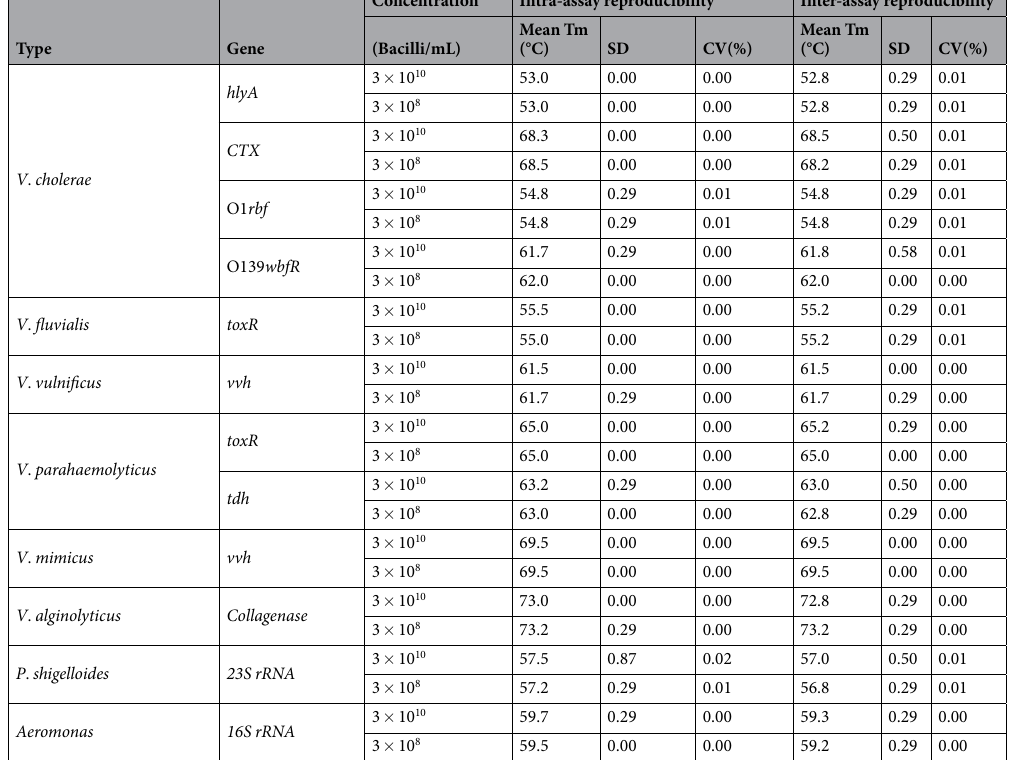
Table 1. Reproducibility of the MLMA assay.